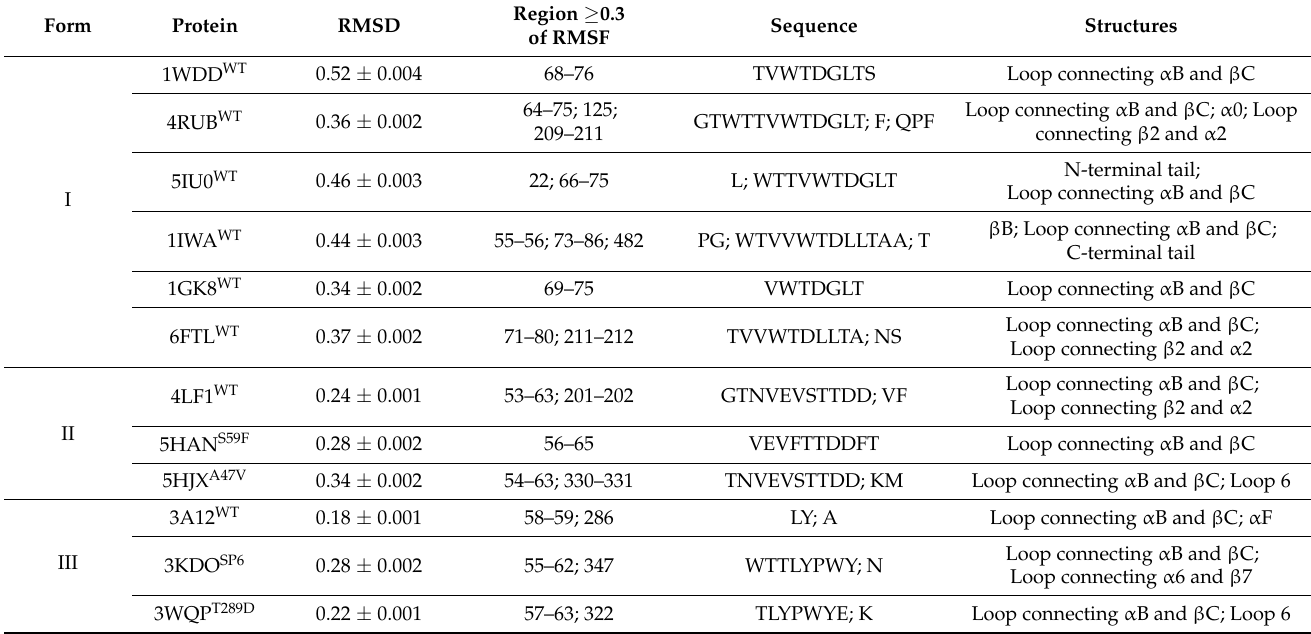
Table 1. Average and standard error of RMSD in 12 RbcL structures. Regions were chosen according to their residues with the highest mean RMSF ( ≥ 0.3